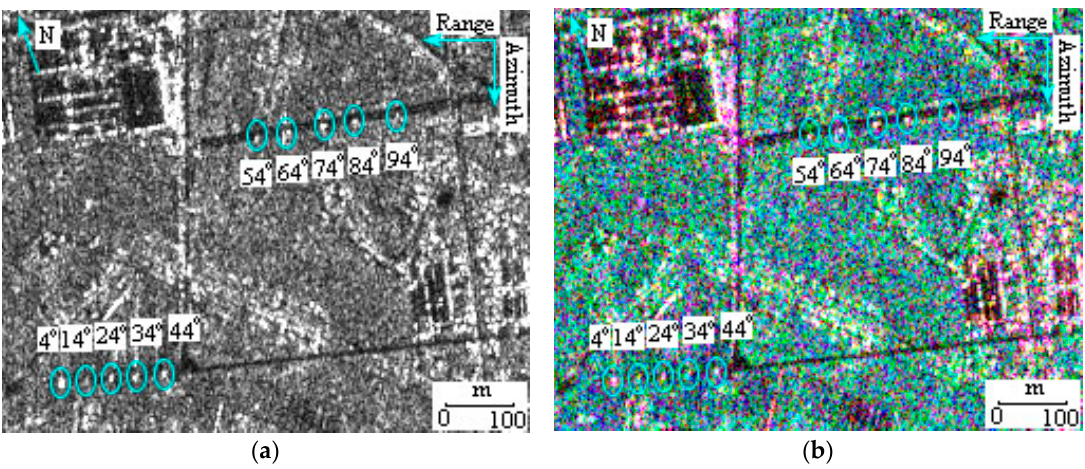
Figure 5. Ten larger trucks circled by cyan ellipses are parking at the consecutive intersection angles from 4 ◦ to 94 ◦ in FP image. ( a ) The total scattered power (SPAN) image; and ( b ) Pauli red-blue-green (RGB) composition image (Red: | β | 2 , Green: | γ | 2 , and Blue: | α | 2